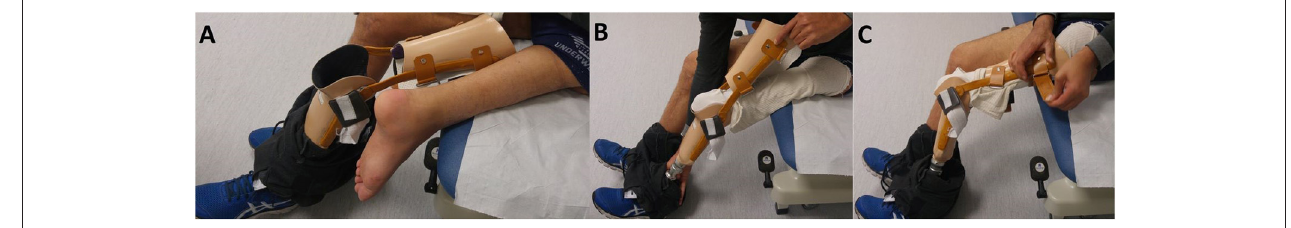
FIGURE 6 | (A,B,C) Installation of the